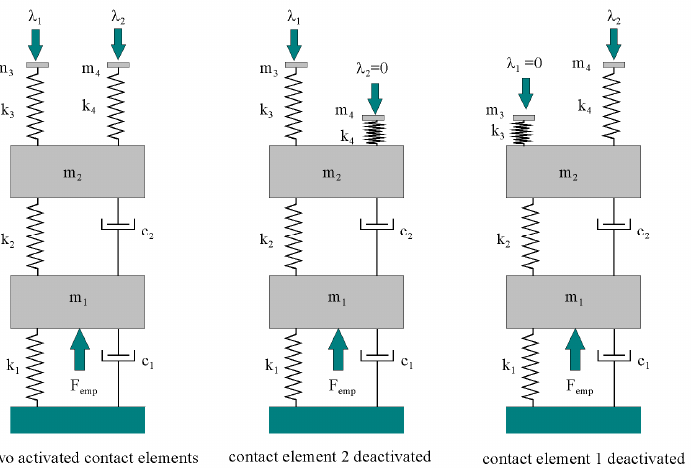
Figure 6. Pantograph with different activation cases in the contact elements.